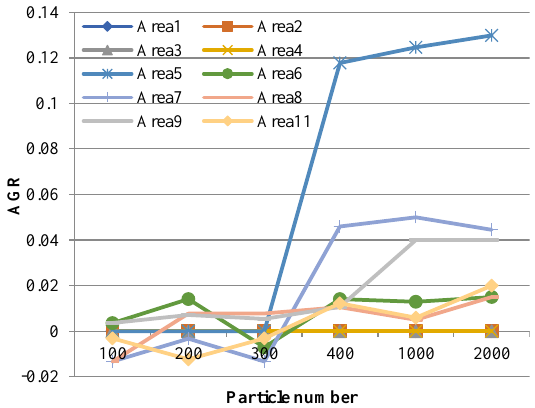
Figure 4. Relationship between accuracy growth rate and particle number.